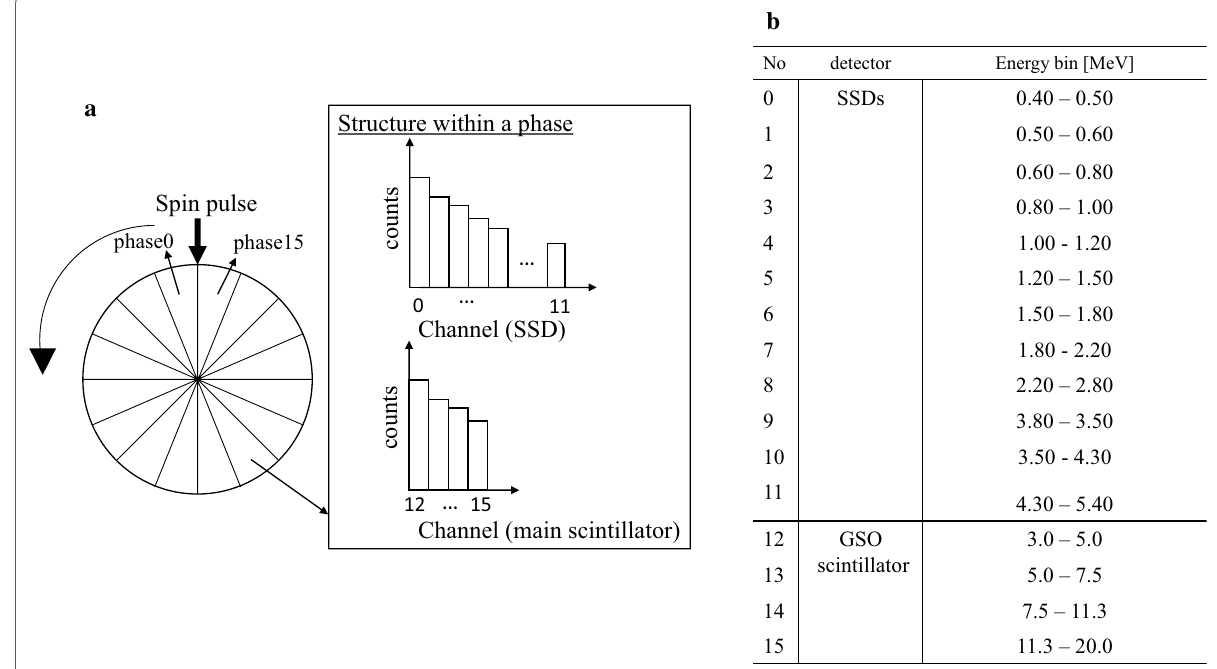
Fig. 6 a The definitions of the spin phases and energy channels in each spin phase. b The definition of the energy ranges of each energy